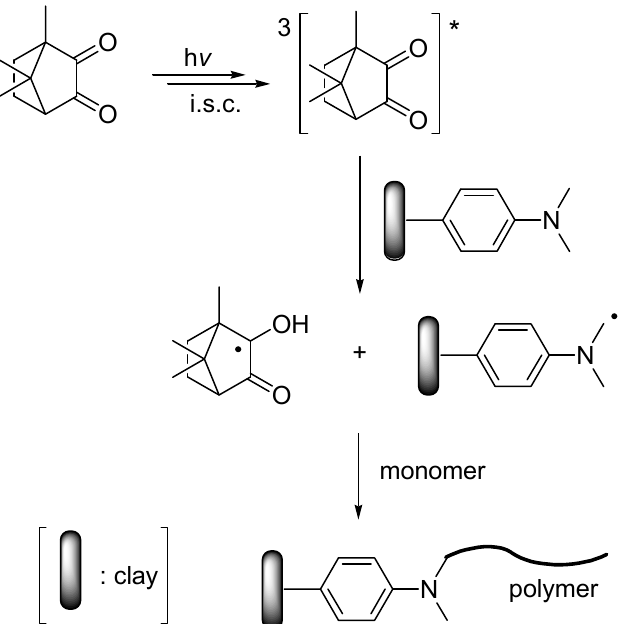
Scheme 2. Mechanism of visible light photopolymerization on the clay surface by using camhorquinone. The structure of the attached azoic initiator is simplified for the sake of